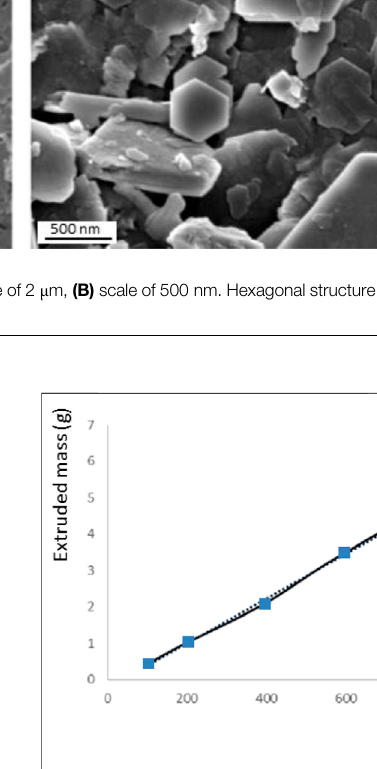
FIGURE 2 | Collected data of extruded mass with imposed fl ow. Flow is without unit, taken as in the hardware. It corresponds to an activation of the stepper motor of the extruder, and it is compatible with the G-code which controls